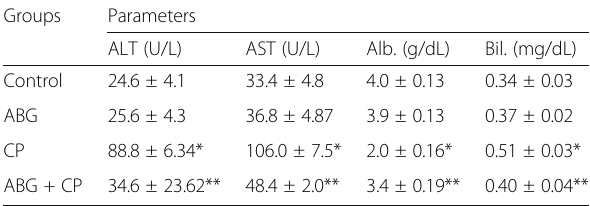
Table 2 Ameliorative effect of aged black garlic (ABG) on the level of some serum biochemical parameters of the cyclophosphamide (CP)-treated rats Groups